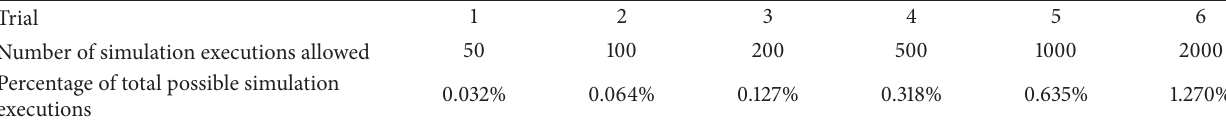
Table 1: Number of simulation executions allowed for each experimental trial.